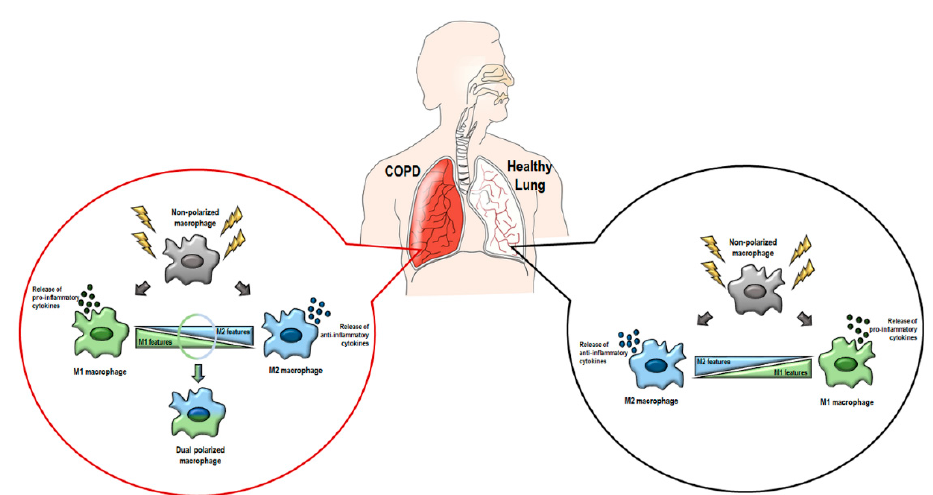
Figure 2. A representative illustration of the macrophage subtypes in COPD and healthy lungs. In healthy lungs (right circle), upon stimulation, macrophages could be polarized in an M1 (green) or M2 (blue) phenotype. In COPD lungs, at least four macrophage subtypes exist (left circle): non- polarized macrophages (gray), M1 macrophages (green), M2 macrophages (blue), and dual-polarized macrophages (half-green and